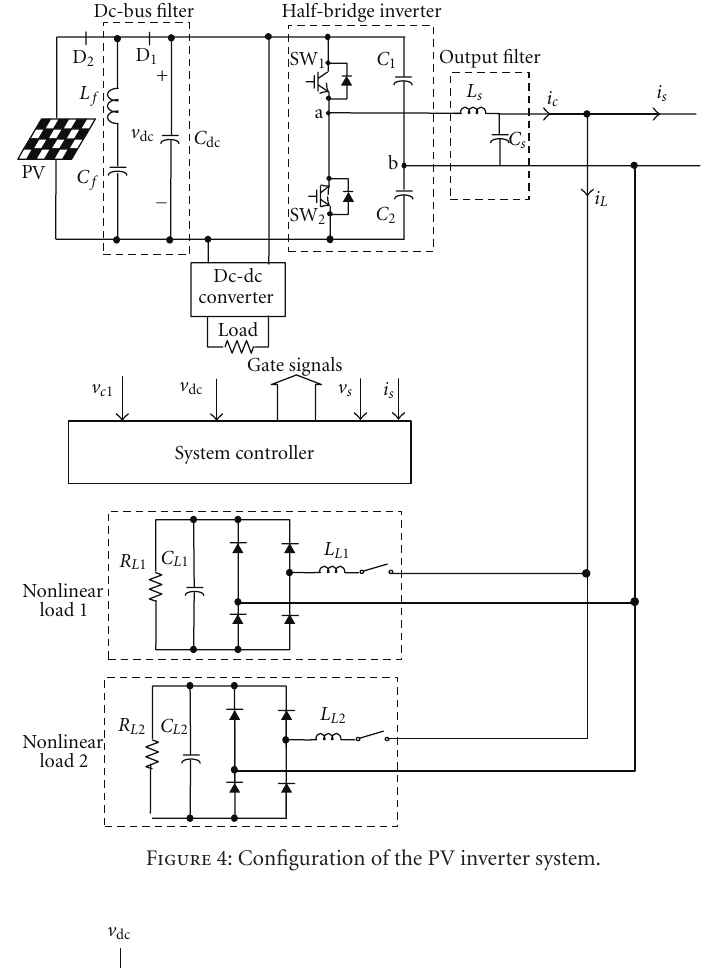
Figure 4: Configuration of the PV inverter system.